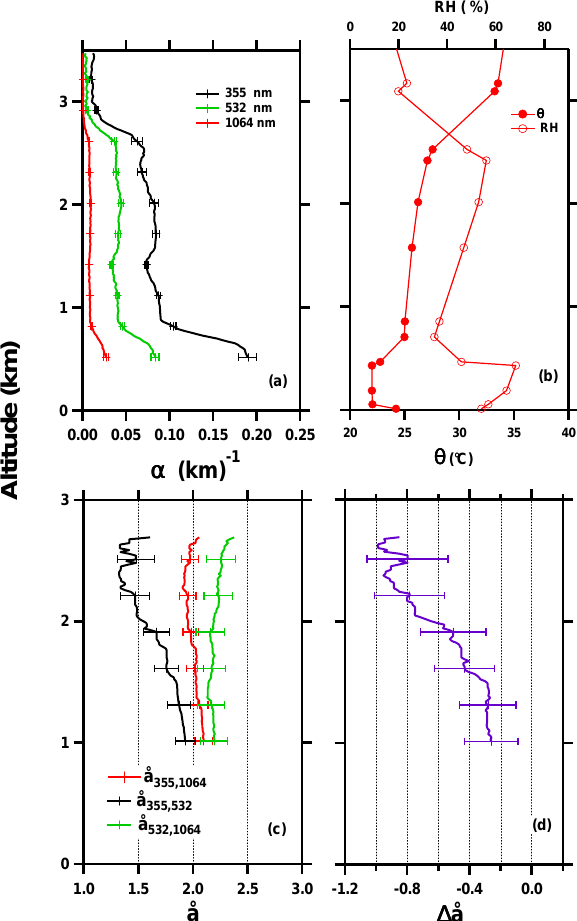
Fig. 11. (a) Extinction coefficient profiles at 355nm (black line), 532nm (green line), and 1064nm (red line) retrieved from li- Figure 11 (M. R. Perrone et al.) 5 dar measurements performed on 3 October 2011 from 12:41 to 13:16UTC. (b) Vertical profiles of potential temperature ( θ) and relative humidity (RH) retrieved from radio sounding measurements performed at 11:00UTC. Vertical profiles of (c) the Ångstrom ex- ponents å 355 , 532 (z) , å 532 , 1064 (z) , å 355 , 1064 (z) , and (d) the spectral curvature 1 å (z) .